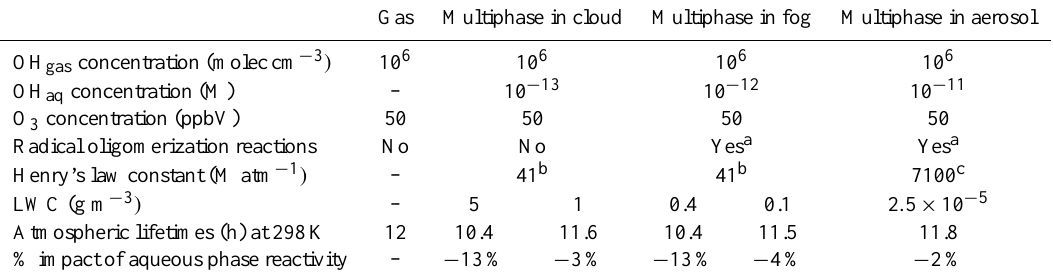
Fig. 12. Estimated ranges of the ratios of unsaturated dissolved organic carbon concentration to oxygen concentration (in MM − 1 ) in at- mospheric waters. The straight lines delimit the values for which radical oligomerization dominates over O 2 addition, as determined by the present work (see text). Table 3. Comparison of MVK atmospheric lifetimes between its gas phase reactivity only and its multiphase reactivity, taking into account its air/water partitioning at Henry’s law equilibrium, its gas and aqueous phase reactivity: oligomerization is considered only in fogs and aerosol media, with k oligo values derived from our experimental results. Gas Multiphase in cloud Multiphase in